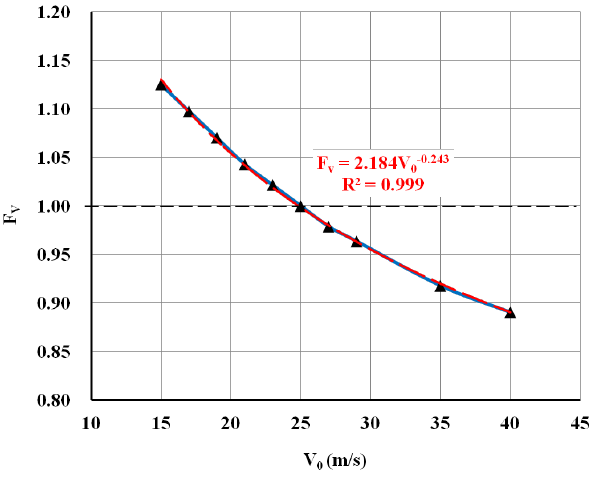
Figure 6. Displacement controlling mass factors for two sets of impact conditions of the R-2 Fig. 6. Displacement controlling mass factors for two sets of im- pact conditions of the R-LPR structure resulting in the same speci- LPR resulting into the same specified impact energy of 150 kJ. The first is with 1.0-ton block 3 fied impact energy of 150kJ. The first is with 1.0-ton block and the and the second with 0.5-ton block. The shown correlation equation is with the 1.0-t mass. 4 second with 0.5-ton block. The shown correlation equation is with the 1.0-ton mass.